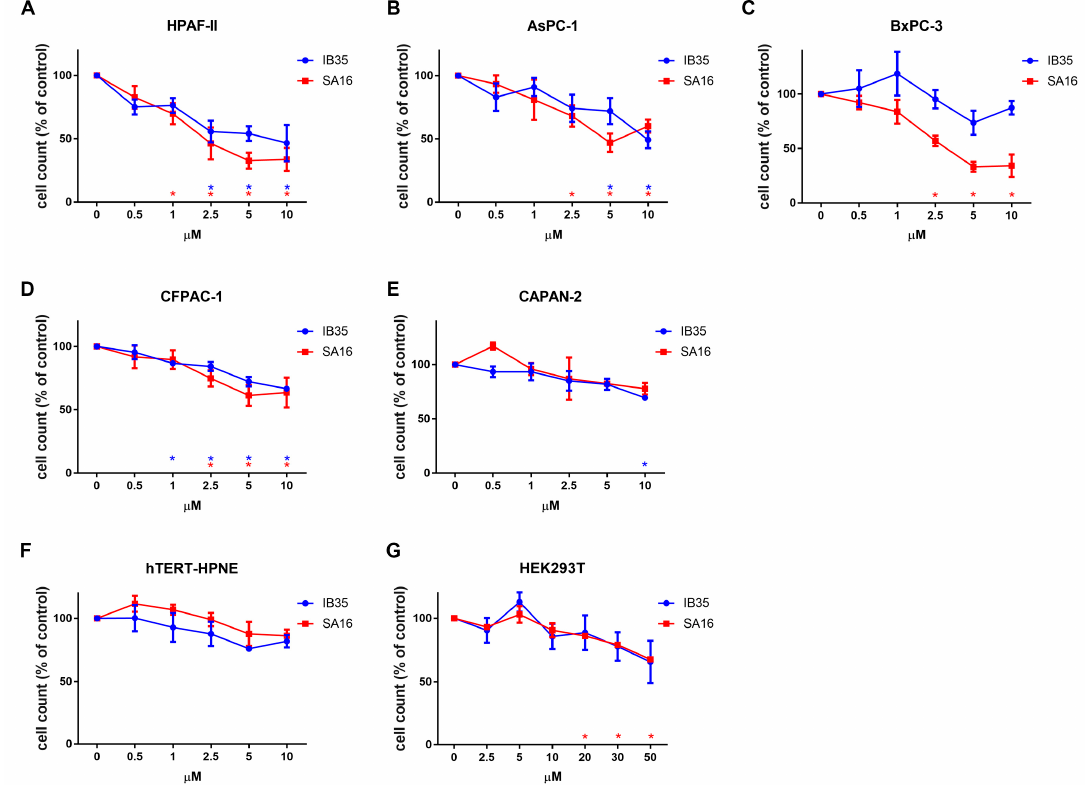
Figure 1. Dual 3-phosphoinositide-dependent kinase 1 (PDK1)/Aurora A inhibitors reduce pancreatic cancer cell number. HPAF-II ( A ), AsPC-1 ( B ), BxPC-3 ( C ), CFPAC-1 ( D ), CAPAN-2 ( E ), hTERT-HPNE ( F ), and HEK293T ( G ) cells were treated with the indicated concentrations of SA16 and IB35 and the number of cells was assessed after 72 h. Control cells were incubated with vehicle (DMSO, Sigma Aldrich, St. Louis, MO, USA) alone (“control”). Data are expressed as percentage of control cells and are means ± SEM of n = 3 independent experiments performed in duplicate. * in red: SA16; * in blue: IB35 .